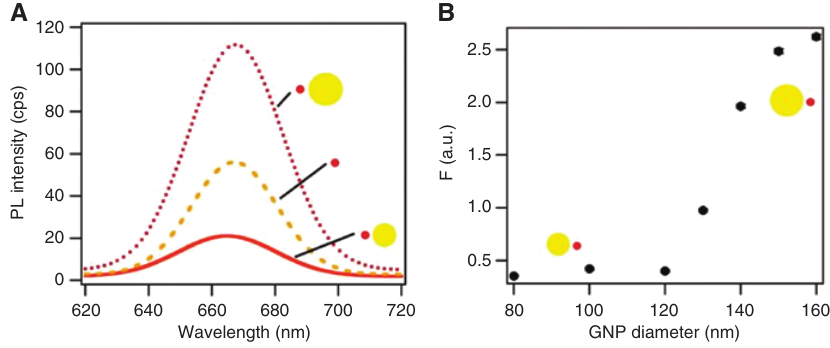
Figure 18: Effect of plasmonic nanoparticle size on photoluminescence of nearby QDs. (A) Fluorescence intensity for bare CdTe/CdS core-shell QDs (middle), with 160 nm AuNPs (top), and with 80 nm AuNPs (bottom). (B) Graph showing the fluorescence intensity of CdTe/CdS QDs near AuNPs of varying sizes. Adapted with permission from Ref. [111]. Copyright 2010 American Chemical